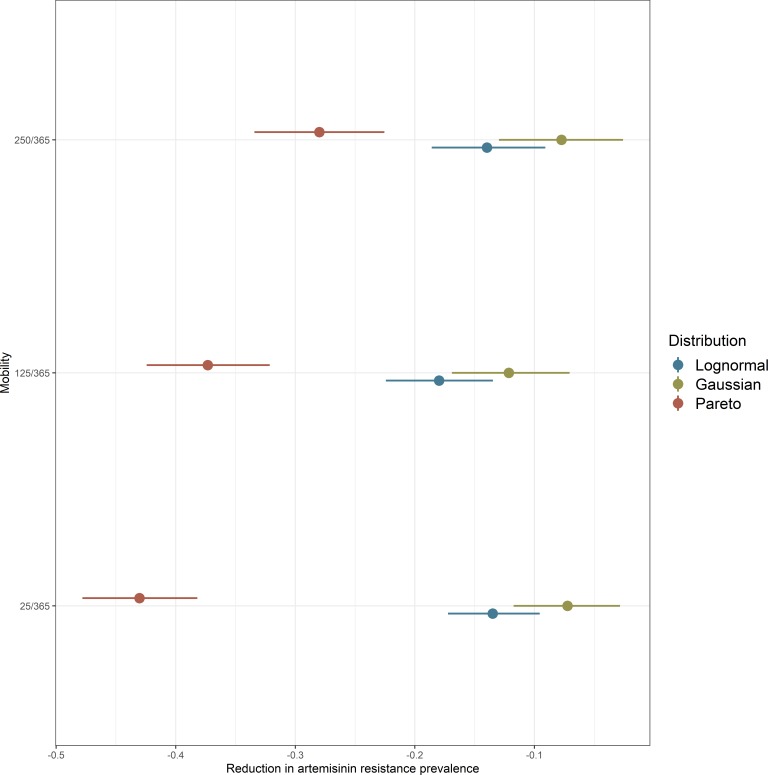
Population movement and mosquito distributions determine artemisinin resistance spread.Illustrates how human population mobility (y-axis) interacts with how transmission risk is distributed over space (colored groups) to modulate the extent to which artemisinin resistance is able to spread (x-axis).